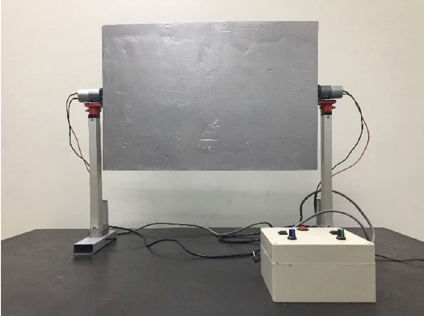
Figure 9: Rotate the frame 90 ° facing the operator and at the lower position.